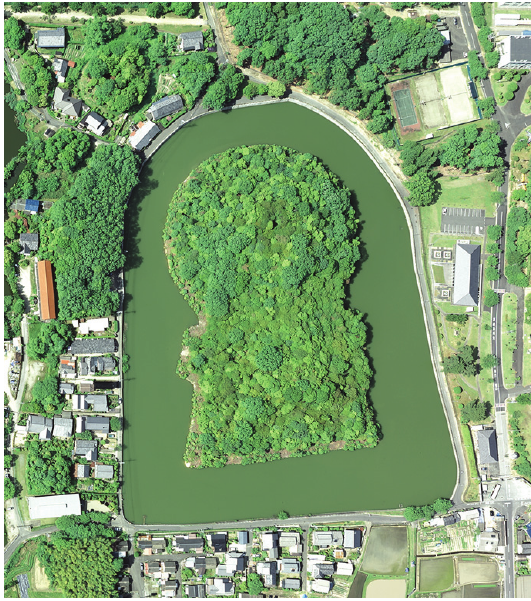
Fig 4. Konabe Mounded Tomb (Photo Image by DMC )